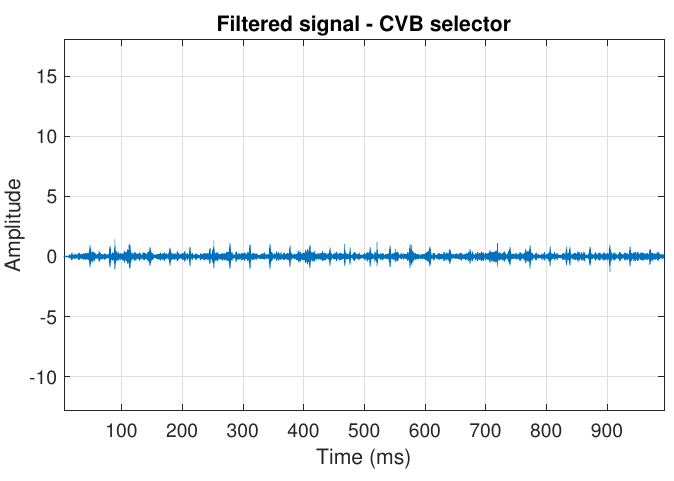
Figure 25. Filtered signal s 3 by CVB selector.